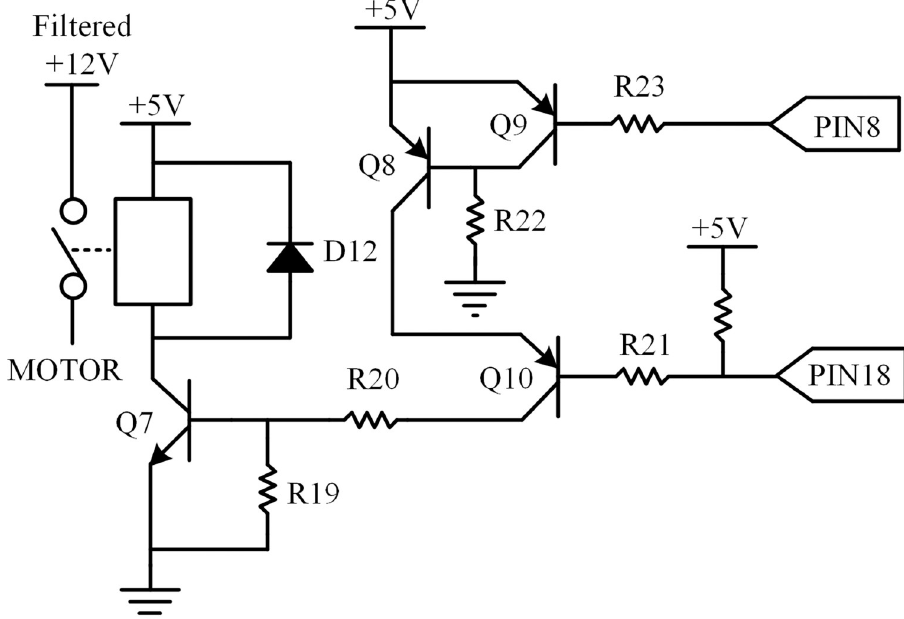
Fig 7. Schematic of the relay control